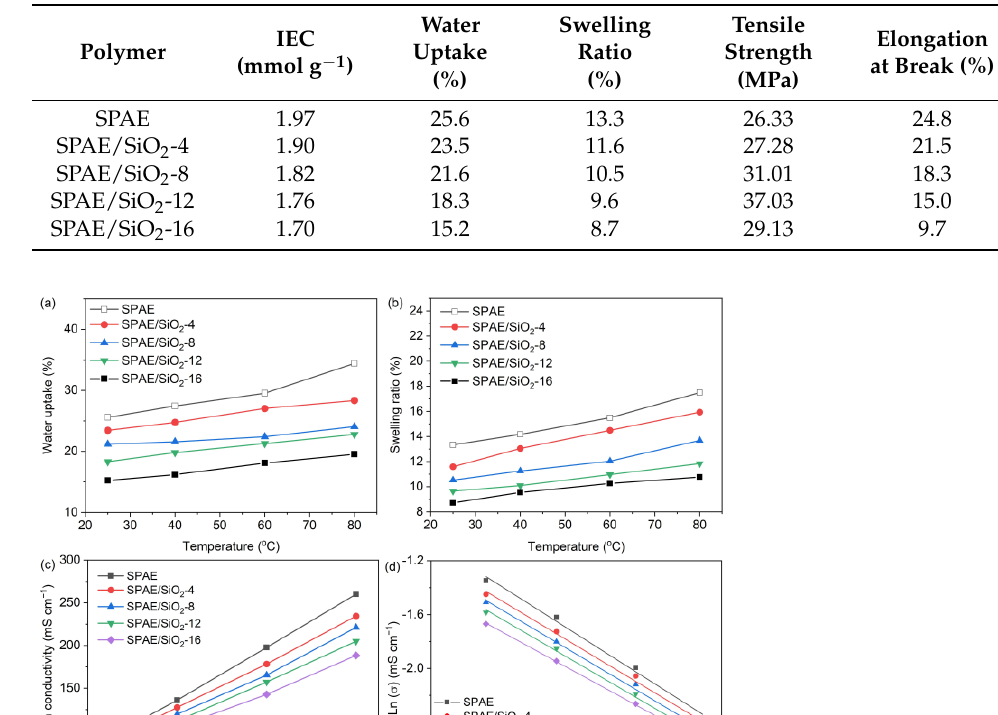
Table 1. Basic properties of the SPAE and SPAE/SiO 2 composite PEMs at room temperature.